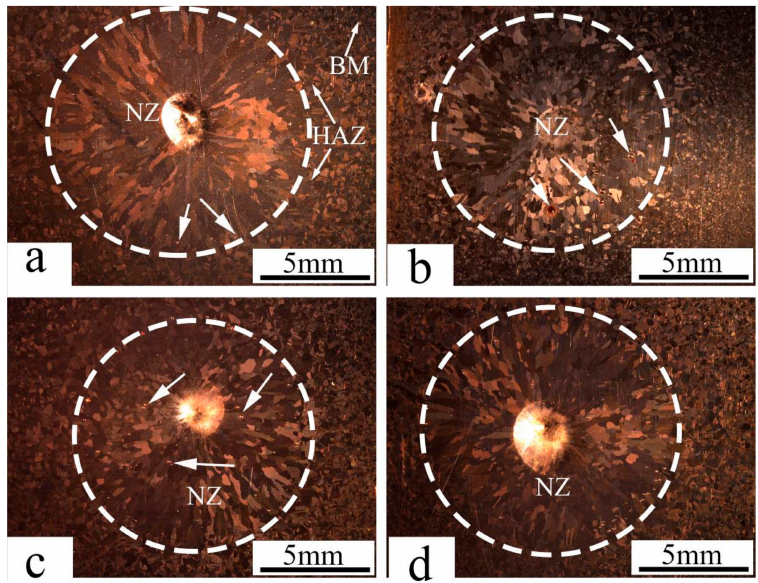
Figure 3. The macrostructure of GTA spot-welded copper joints with the assistance of ultrasonic vibration (USV) for ( a ) 0 s (without USV); ( b ) 2 s ; ( c ) 4 s; and ( d ) 6